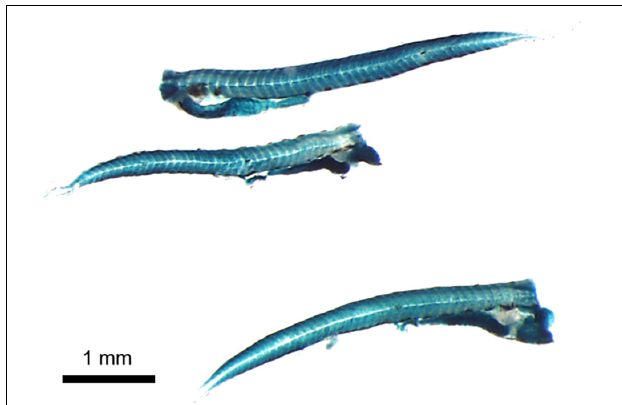
FIGURE 3 | Larval King George whiting following confirmation of identification using the in situ hybridization (ISH) molecular technique. Larvae were viewed at 20 × magnification under a dissecting microscope. The head of each larva was removed to prevent potential contamination of the otoliths.